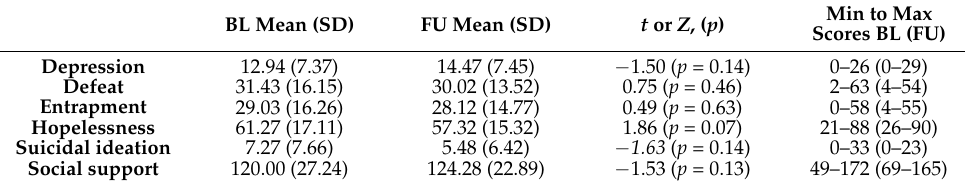
Table 1. Descriptive data for all assessed variables at baseline and four-month follow-up time